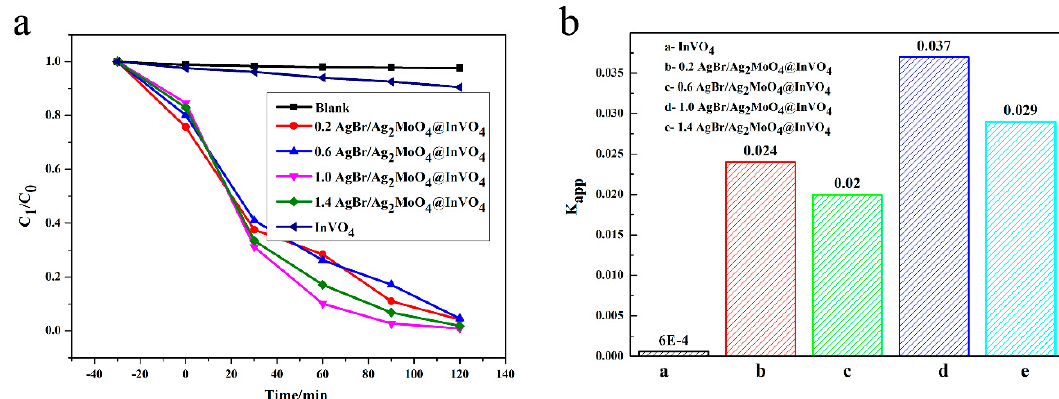
Figure 4. ( a ) Degradation performance of ciprofloxacin (CIP) solution in the presence of different photocatalysts, ( b ) the first-order kinetic constants of CIP degradation for different photocatalysts.